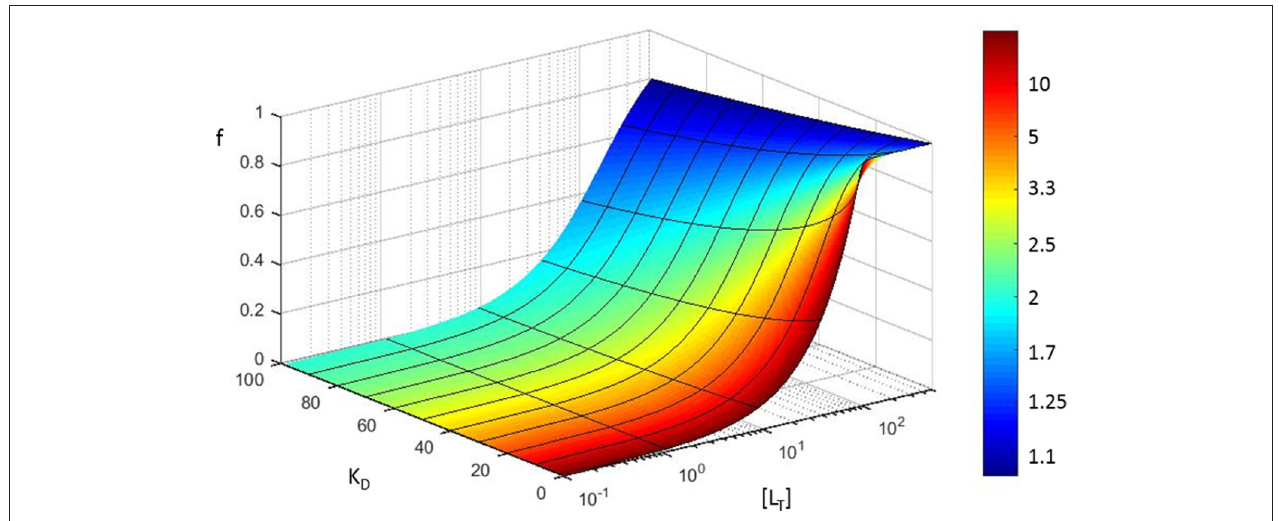
FIGURE 6 | Error propagation in fitting a saturation curve to determine the K D of a protein-protein interaction. Based on a simple model (see section Error propagation in the affinity constant), fractional receptor saturation (f) is shown as a function of the total concentration of ligand ([L T ]), for different values of the equilibrium dissociation constant (K D ). The color coding refers to the increase in fractional error on the calculated equilibrium constant (assuming [R t ] = 100nM, all concentrations in